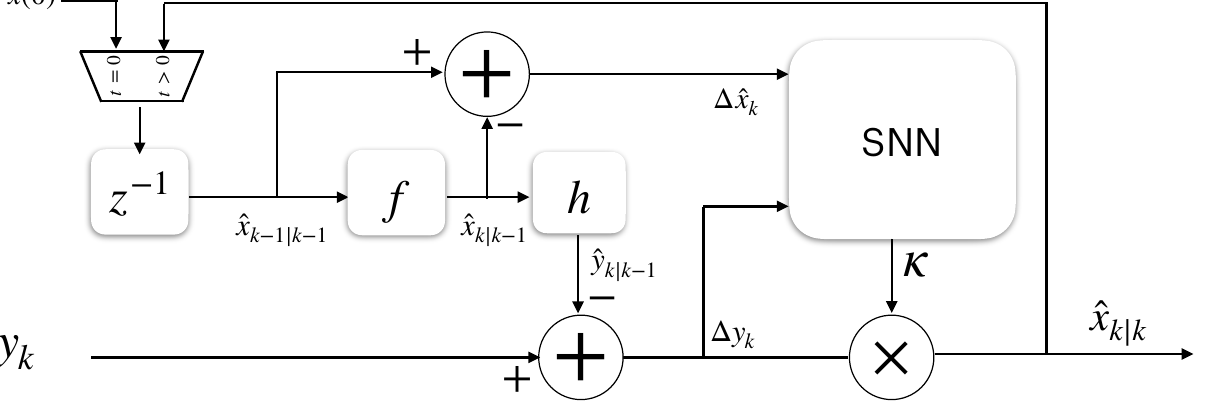
Figure 4. Block diagram of the Kalman filter in which the typical Kalman gain-obtaining procedure is replaced by an